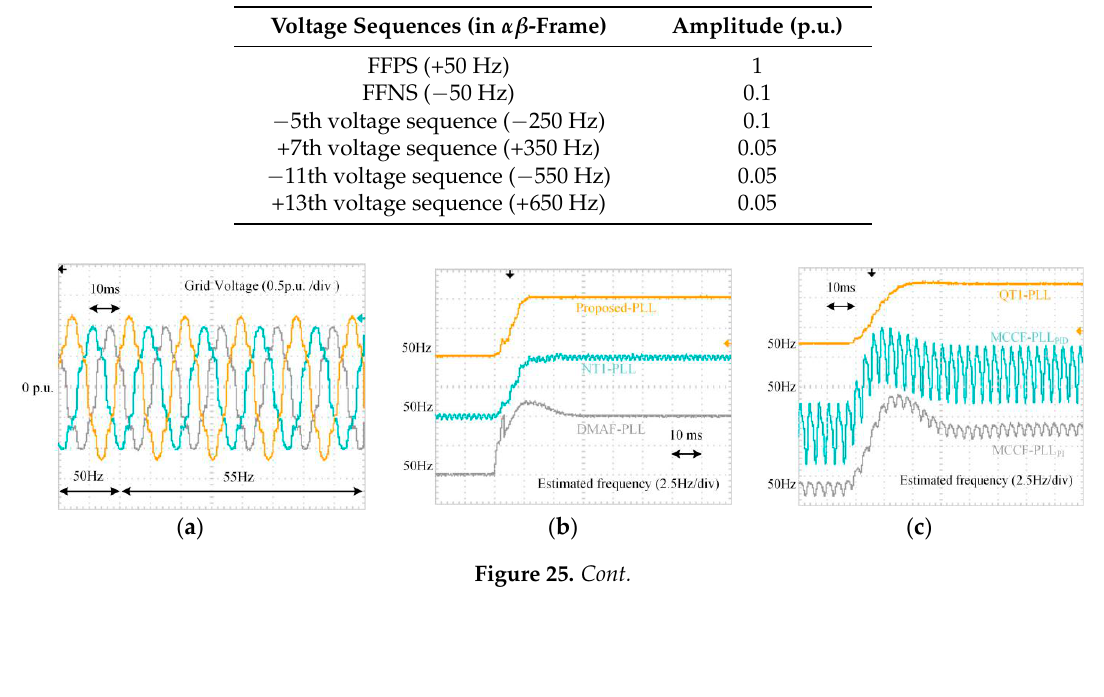
Table 4. Distorted grid voltage components.